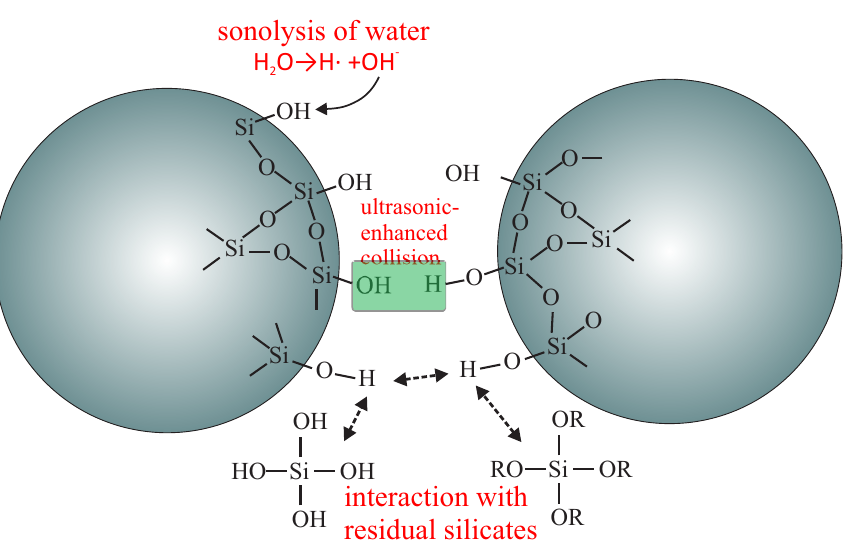
Figure 5. Proposed mechanism for agglomeration of silica spheres through the ultrasonic-enhanced